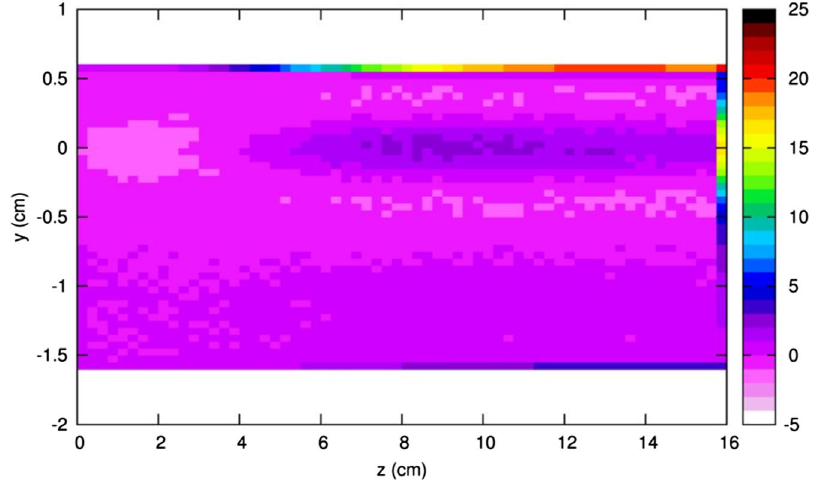
FIG. 11. Net deposited charge in the yz plane for all x [charge/cc/proton].